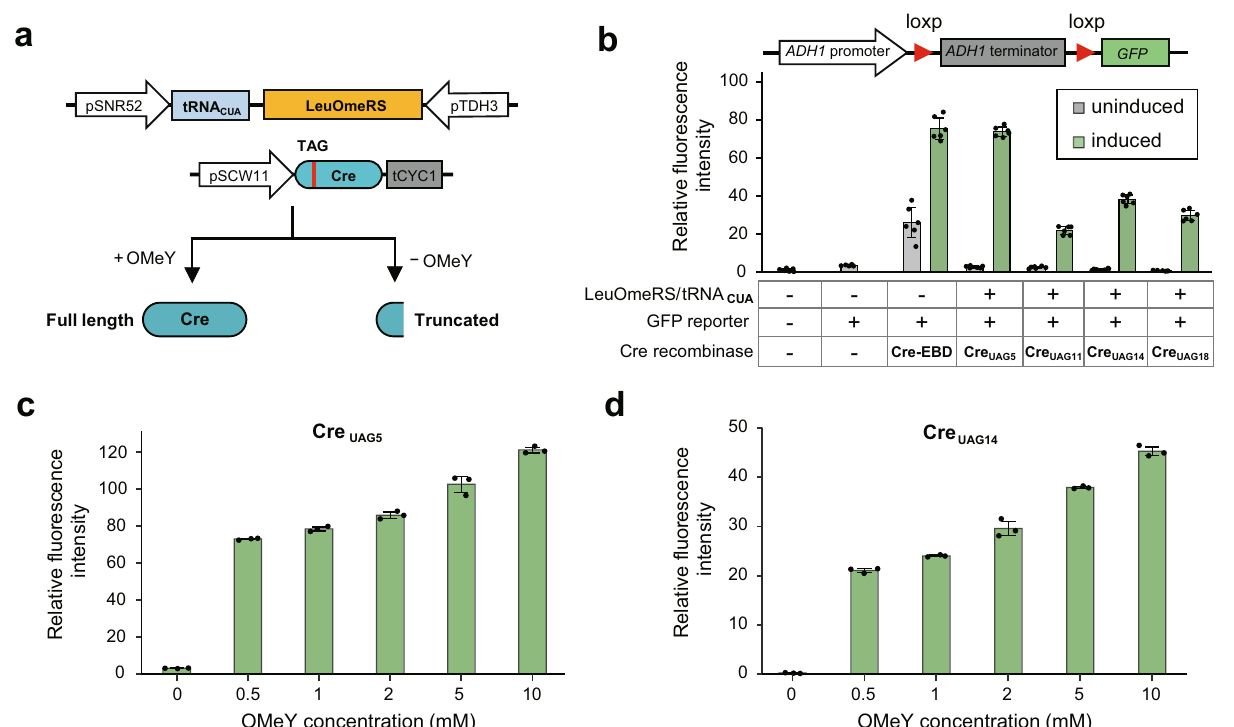
Fig. 1 | The GCE-SCRaMbLE system is designed for tight and tunable control of Cre recombinase expression. a Schematic representation of GCE-SCRaMbLE system, which utilizes the engineered leucyl-tRNA synthetase/tRNA (LeuOmeRS/ tRNA CUA ) pair to incorporate OmeY into Cre recombinase in response to the TAG stop codon. The expression of full-length Cre enzyme depends on the presence of OmeY in the medium. b Measurement of recombination ef fi ciency mediated by GCE-SCRaMbLE. Recombination ef fi ciency was determined using a previously described reporter plasmid bearing a loxP- fl anked ADH1 terminator cassette between ADH1 promoter and the coding region of GFP gene 17 . The loxP sites are shownastriangles inred.Wild-type yeast cells (BY4741)co-expressing LeuOmeRS/ tRNA CUA pair, GFP reporter and Cre recombinase variants (Cre UAG5 , Cre UAG11 ,